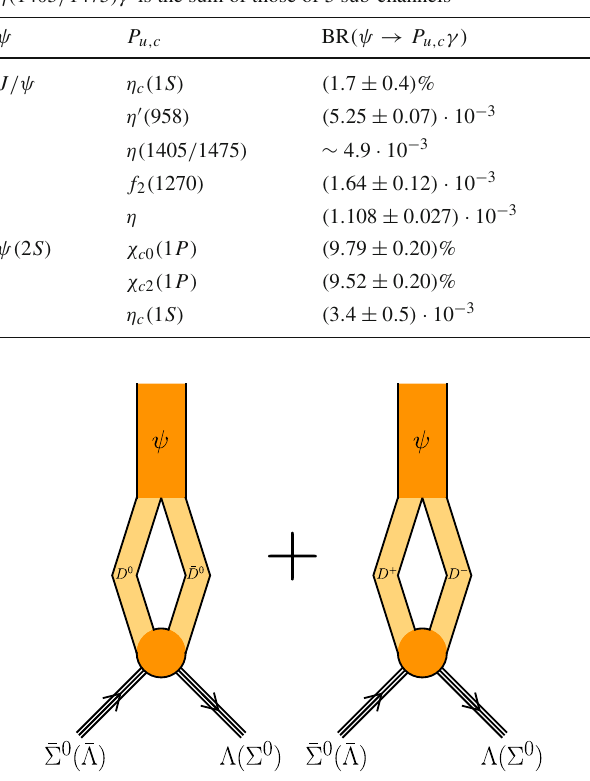
Fig. 5 Feynmandiagramsoftheprocesses ψ → D 0 ¯ D 0 → (cid:3)(cid:4) 0 + c.c. and ψ → D + D − → (cid:3)(cid:4) 0 + c.c. representing the